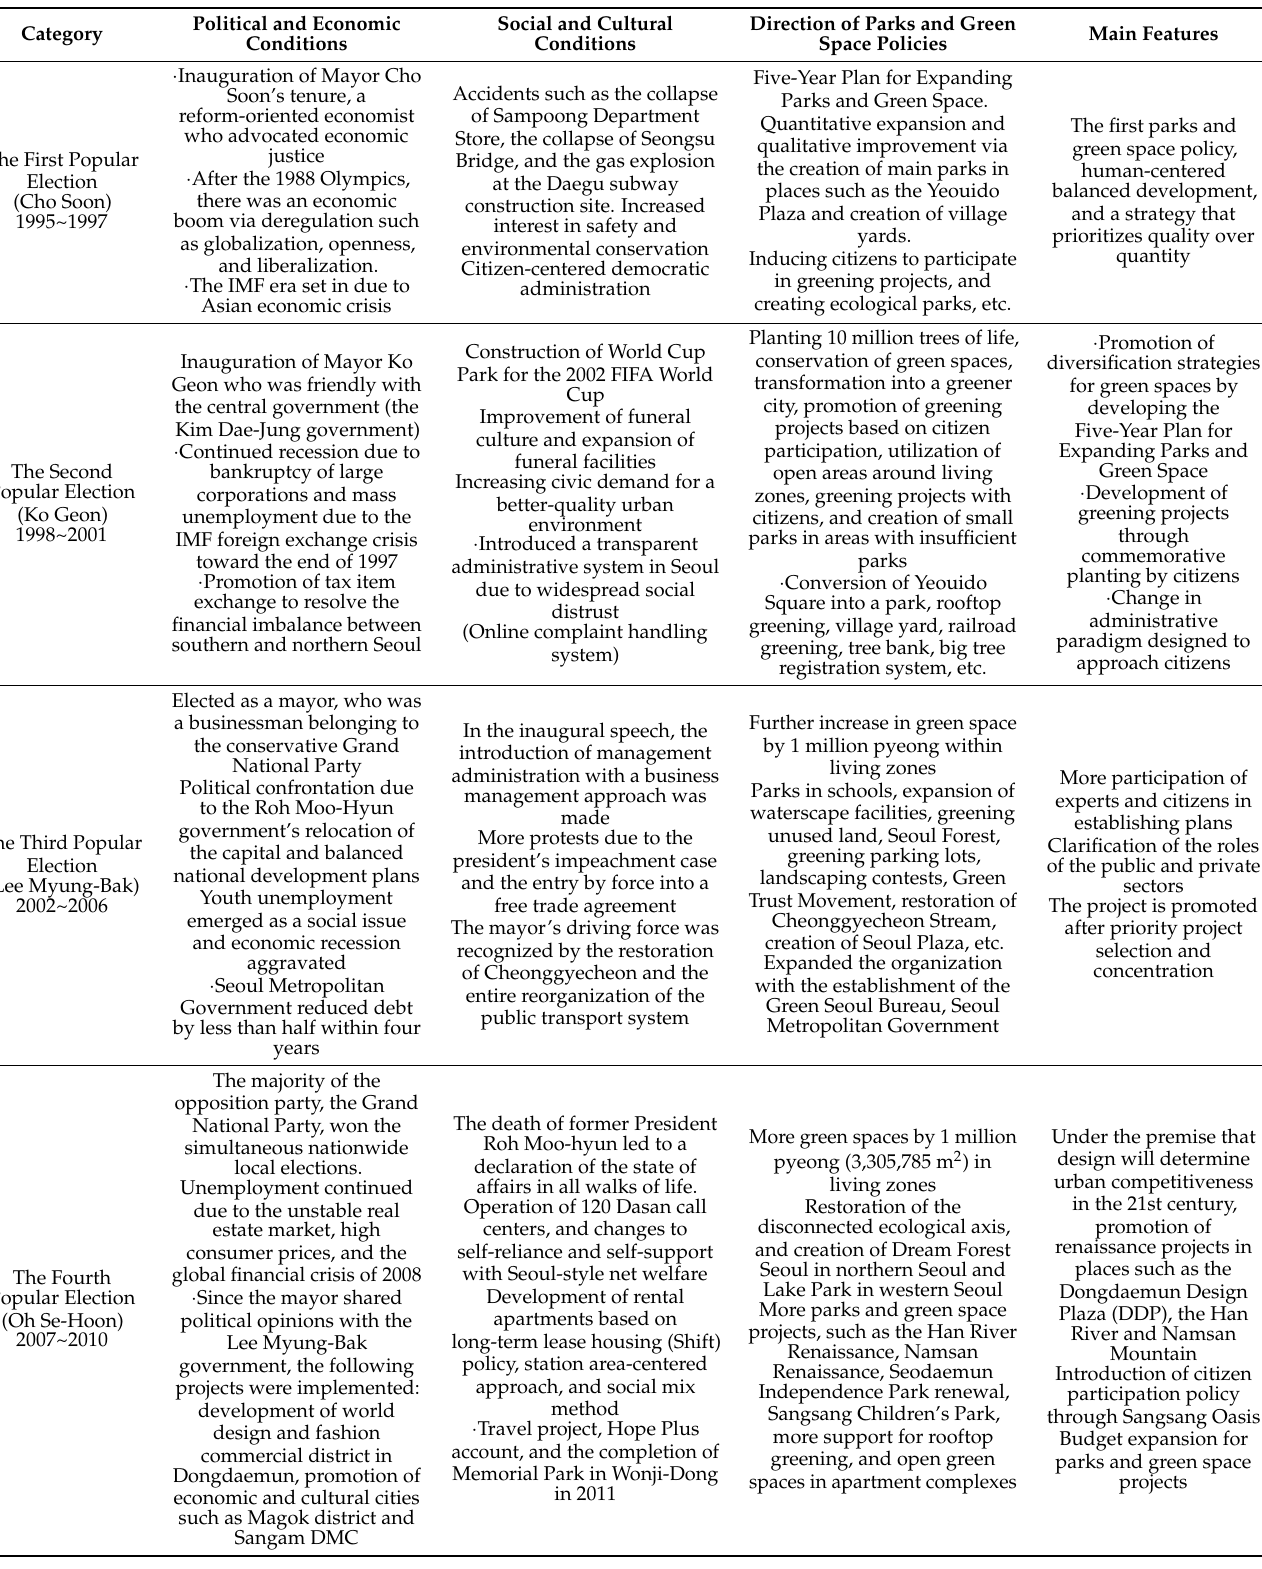
Table 5. Analysis of policies by popularly elected